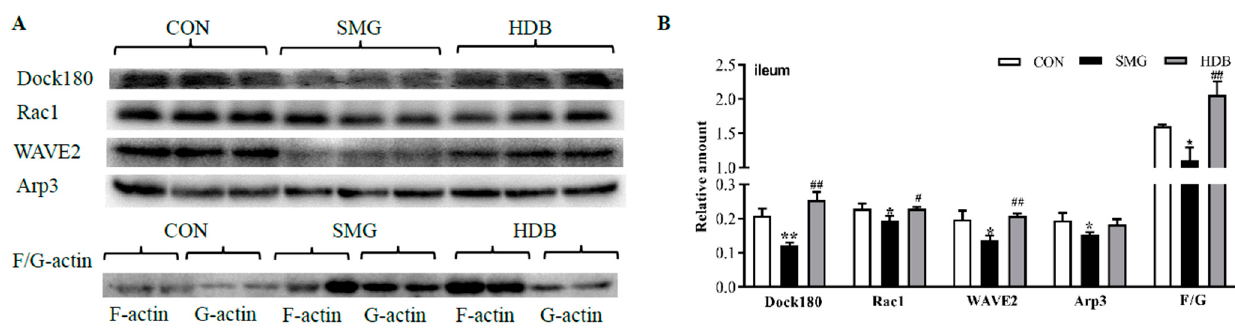
Figure 4. DB increased the expression of Dock180, Rac1, Arp3, WAVE2, and the ratio of F-actin to G-actin in rat ileum. ( A ) the Western-blot bands of Dock180, Rac1, WAVE2, Arp3, and F-actin and G-actin. ( B ) semi-quantitative analysis based on the relative density of the validated proteins. Data was normalized with total protein amount as the internal reference ( n = 9). It indicated DB treatment could dramatically increase expression of these proteins. Note: * p < 0.05 and ** p < 0.01, compared with CON group. # p < 0.05 and ## p < 0.01, compared with SMG group. The relative expression levels of proteins were expressed as the ratio of gray value of the target band to that of total proteins in the same sample. The total protein gel was shown in Supplementary Figure S5.